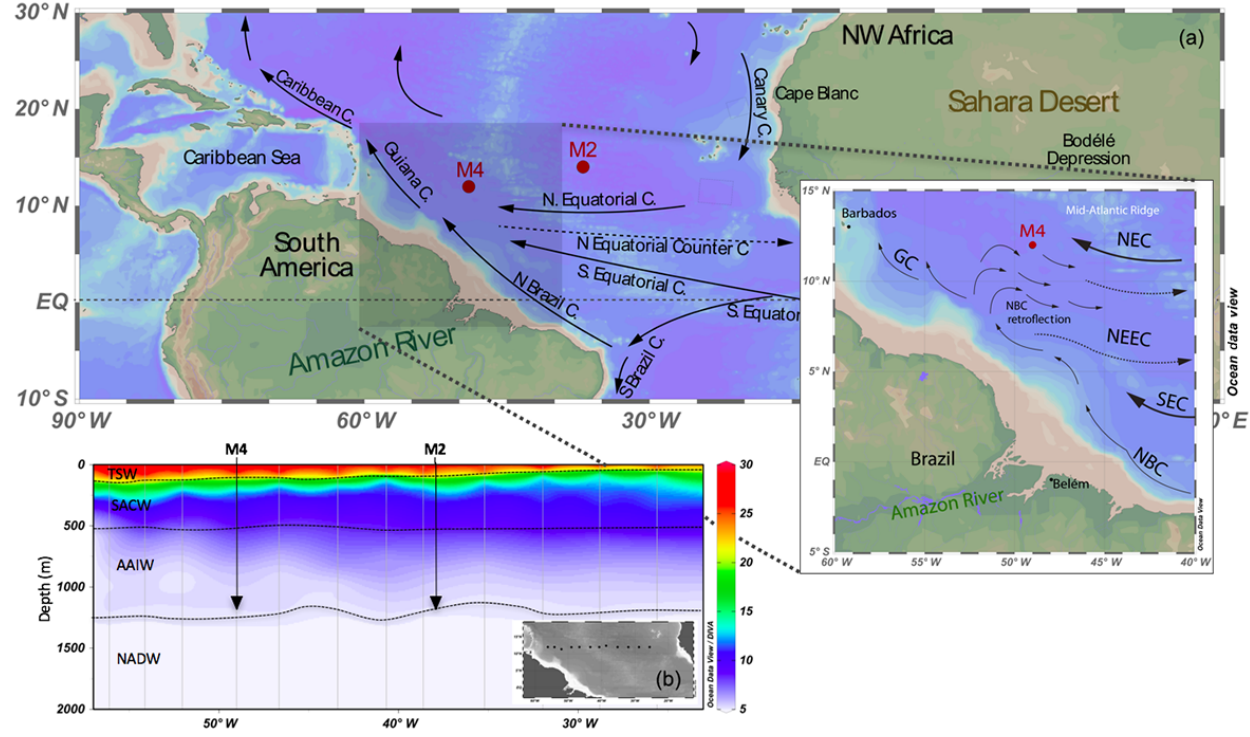
Figure 1. Location of the trap mooring sites M4 and M2 and a schematic representation of (a) the main surface currents in the equatorial Atlantic Ocean, with the inset showing the seasonal eastward retroflection of the North Brazilian Current (NBC) during boreal summer (adapted from Mann and Lazier, 2006). (b) The main water masses present in the study area (TWS – tropical surface water; SACW – South Atlantic Central Water; AAIW – Antarctic Intermediate Water; NADW – North Atlantic Deep Water) based on water depths reported by Emery and Meincke (1986), Reid (1994), and Stramma and Schott (1999) and on water temperature profiles performed along a transatlantic array (12 ◦ N) from 12 January and 2 February 2015 on-board RV Pelagia (cruise PE395; Stuut et al., 2015).